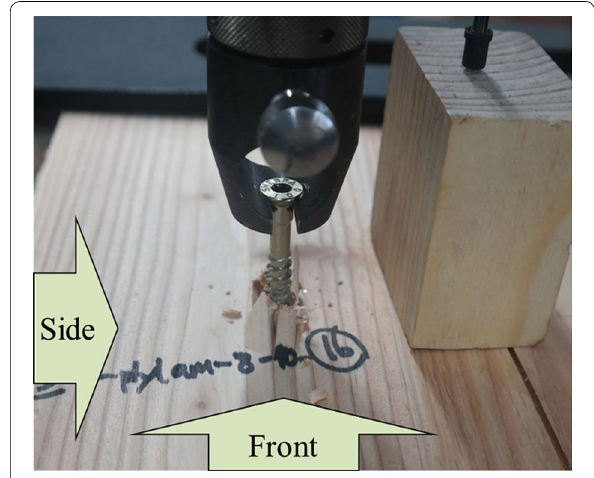
Fig. 5 Failure mode of withdrawal